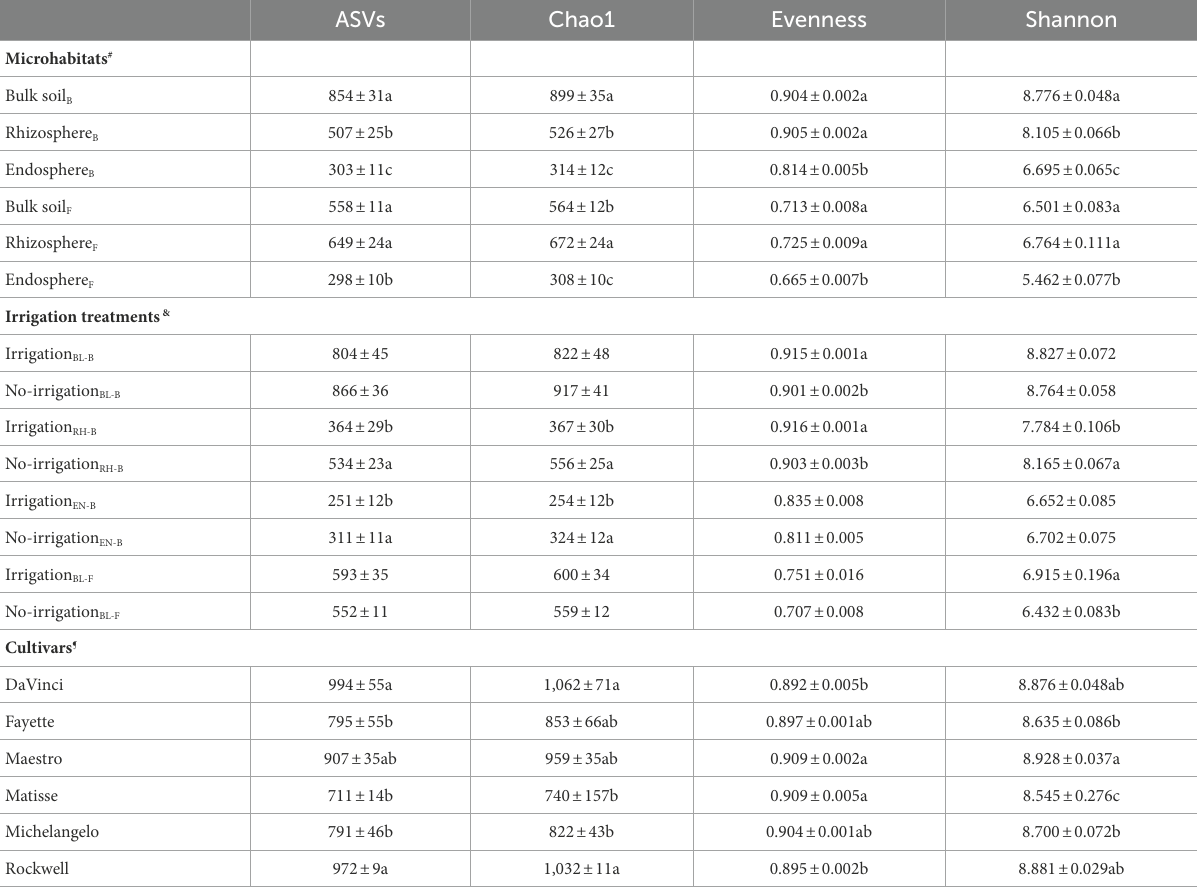
TABLE 2 Alpha-diversity metrics of bacterial and fungal communities as affected by microhabitats (bulk soil, rhizosphere, and root endosphere), irrigation treatments, and different cultivars of tall